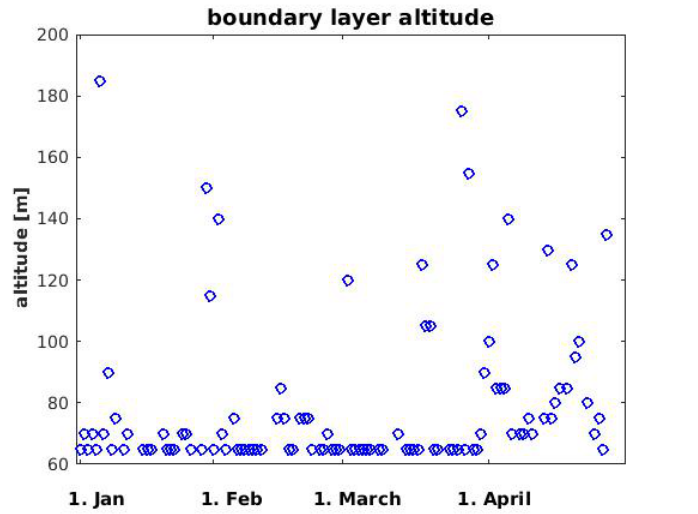
Figure 18. Boundary layer altitude from local radiosonde using the bulk Richardson